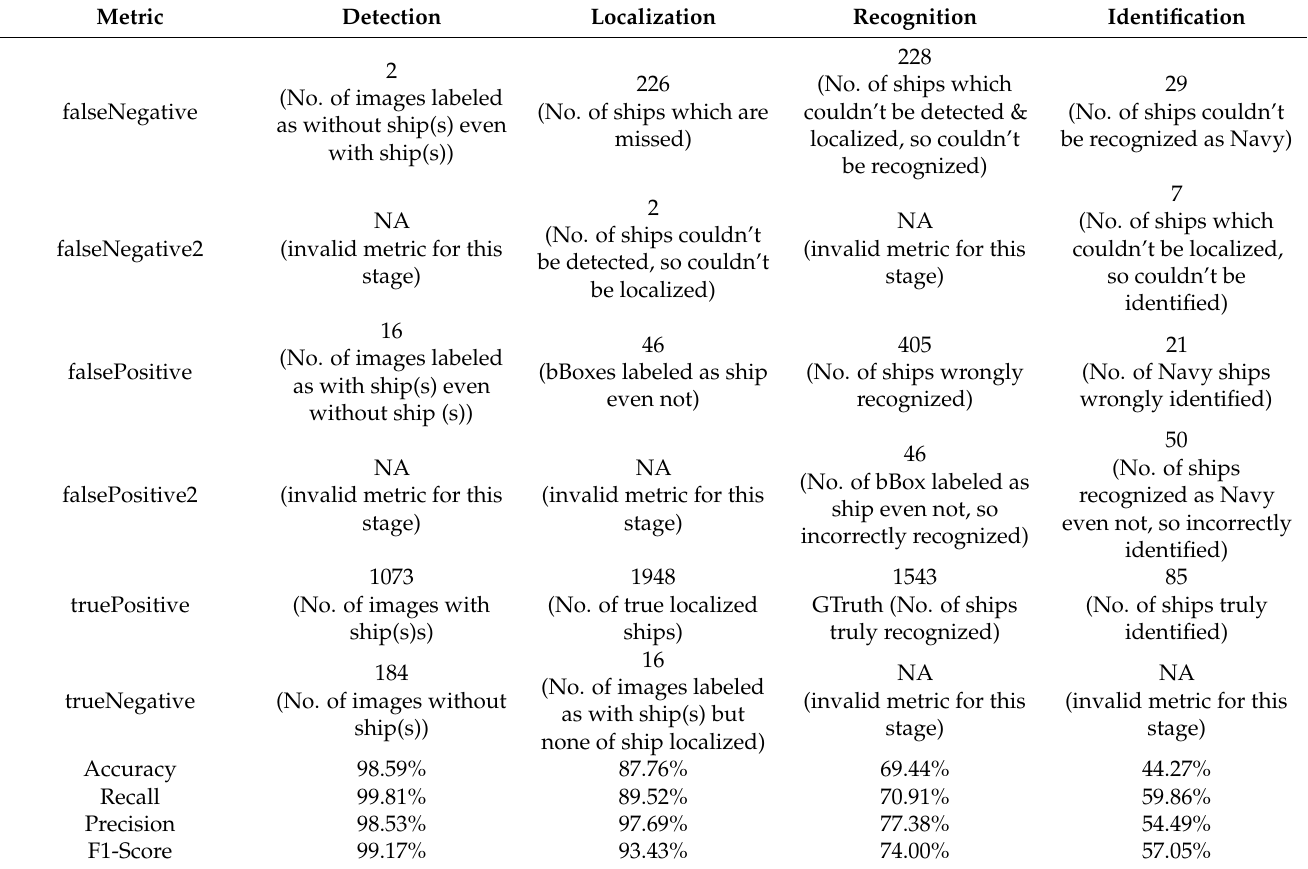
Table 11. The performance of the end-to-end HieD